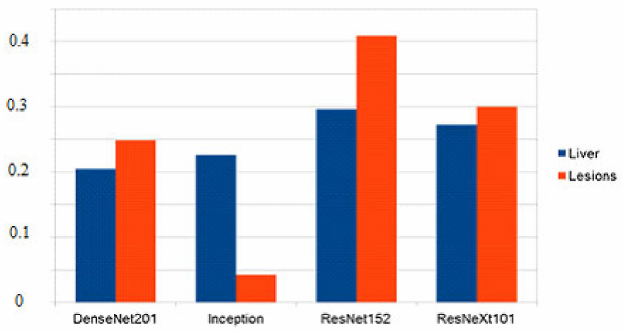
Figure 10. Scaled weights corresponding to each